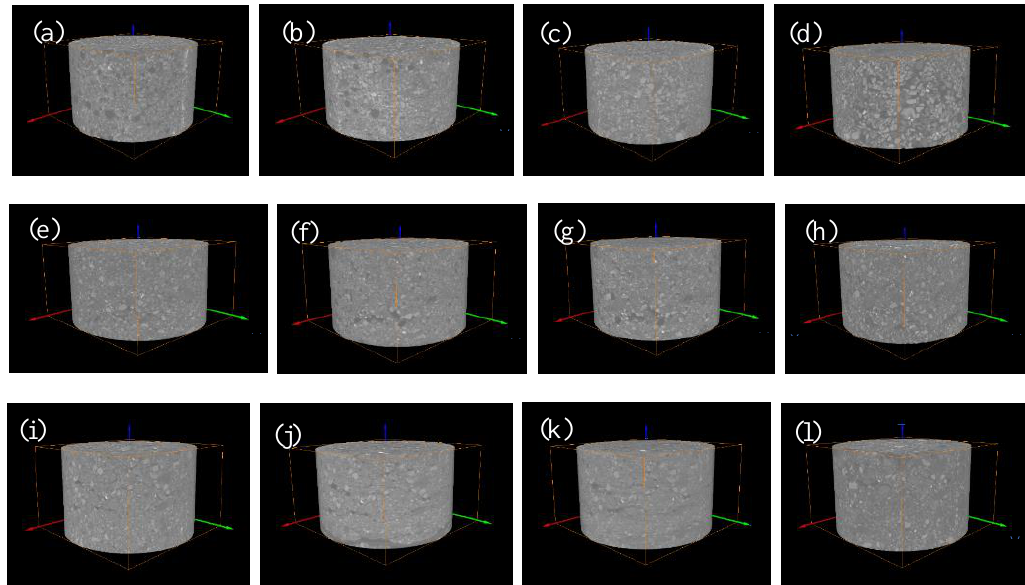
Figure 5. Three-dimensional reconstruction of the three fine-grained tailings samples. ( a ) First-level head of 30% fine content; ( b ) Second-level head of 30% fine content; ( c ) Third-level head of 30% fine content; ( d ) Fourth-level head of 30% fine content; ( e ) First-level head of 50% fine content; ( f ) Second-level head of 50% fine content; ( g ) Third-level head of 50% fine content; ( h ) Fourth-level head of 50% fine content; ( i ) First-level head of 70% fine content; ( j ) Second-level head of 70% fine content; ( k ) Third-level head of 70% fine content; ( l ) Fourth-level head of 70% fine content.